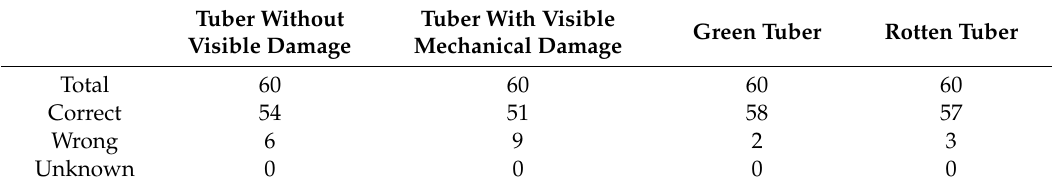
Table 2. Classification statistics for the generated ANN model.